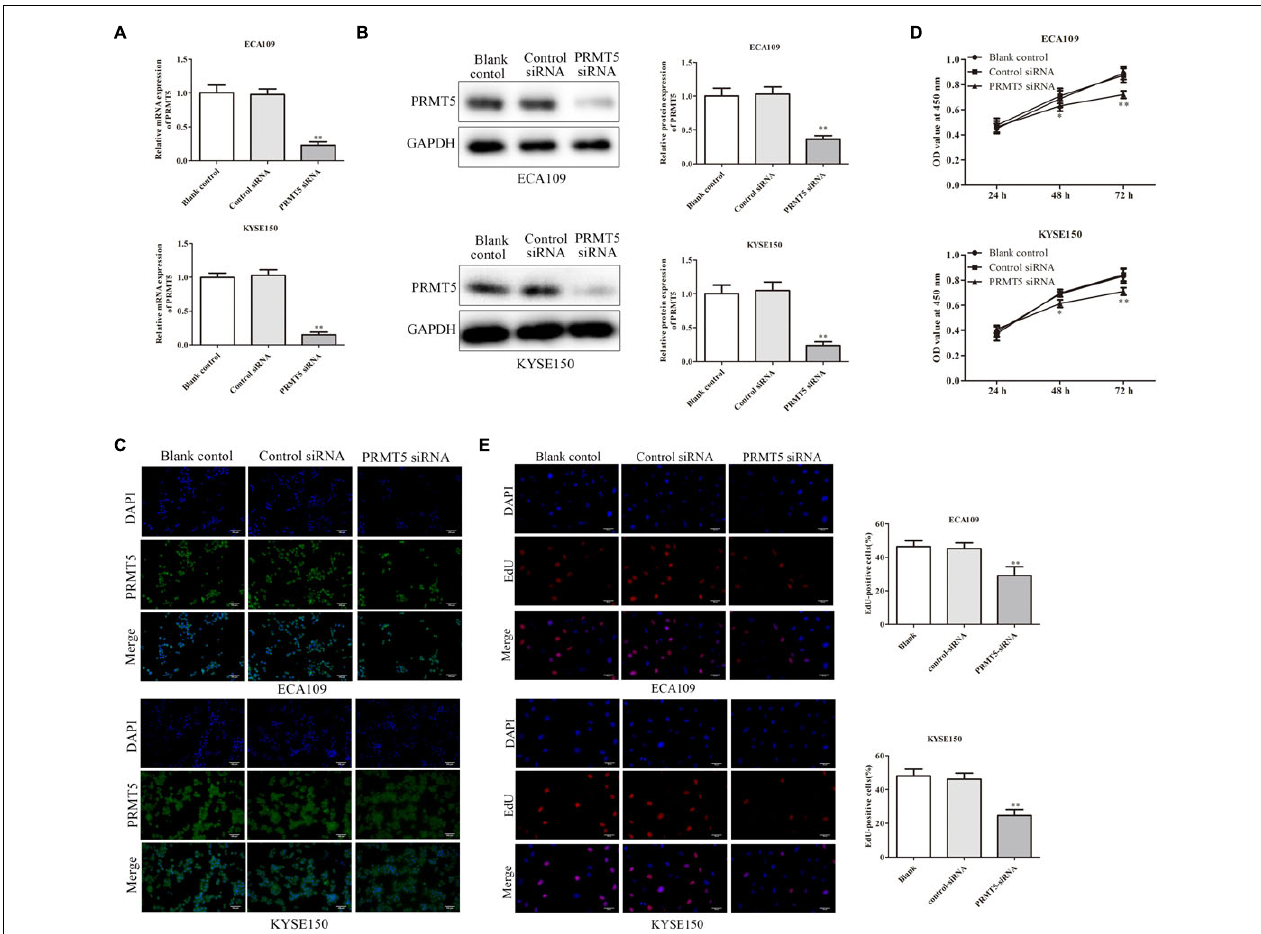
FIGURE 2 | PRMT5 promoted ESCC cell proliferation. (A–C) RT-PCR assay indicated that ECA109 and KYSE150 cells transfected with siRNA PRMT5 significantly downregulated the PRMT5 expression compared with the controls. (B) Western blotting assay indicated that ECA109 and KYSE150 cells transfected with siRNA PRMT5 significantly downregulated the PRMT5 expression compared with the controls. GAPDH was used as a control. (C) Immunofluorescence assay indicated that ECA109 and KYSE150 cells transfected with siRNA PRMT5 significantly downregulated the PRMT5 expression compared with the controls. (D) CCK-8 assay in ECA109 and KYSE150 cells indicated that knocking down PRMT5 expression could inhibit the proliferation rate compared with the controls. (E) EdU assay in ECA109 and KYSE150 cells indicated that knocking down PRMT5 expression could inhibit the proliferation rate compared with the controls. Bars indicate the mean ± SEM, * P < 0.05, ** P < 0.01 vs. control siRNA; magnification × 200. PRMT5, protein arginine methyltransferase 5; CCK-8, Cell Counting